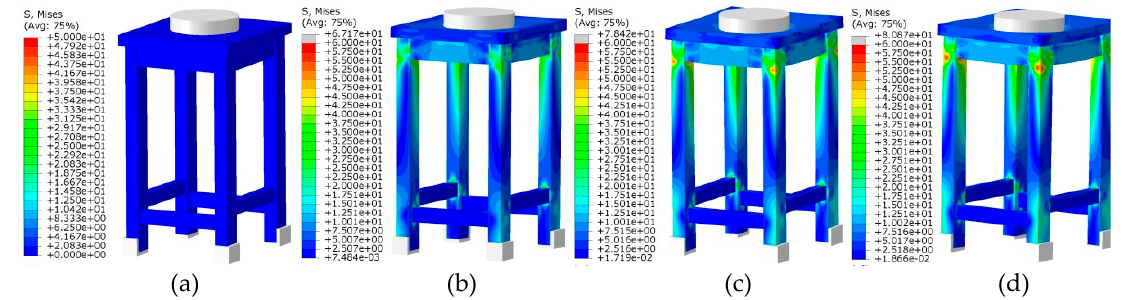
Figure 11. Stress distributions of chair based on FEM ( a ) initial state, ( b ) state at 1 mm-displacement, ( c ) state at 2 mm-displacement, ( d ) state at 3 mm-displacement.